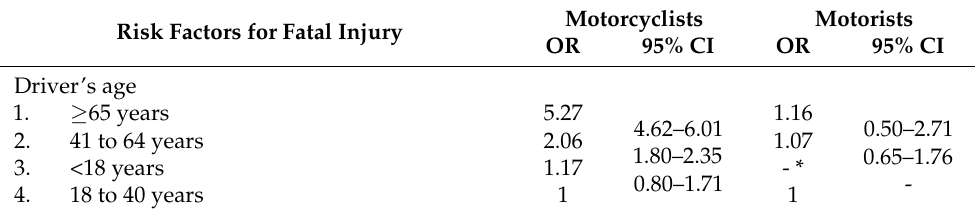
Table 4. Multiple logistic regression results for motorcyclists and